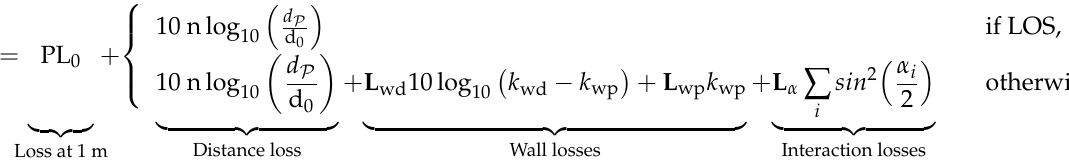
Figure 1. The blue line is the concatenated geodesic path blue and red diamonds represent the points at which walls are crossed along the geodesic path and direct path walls crossings are enumerated by k